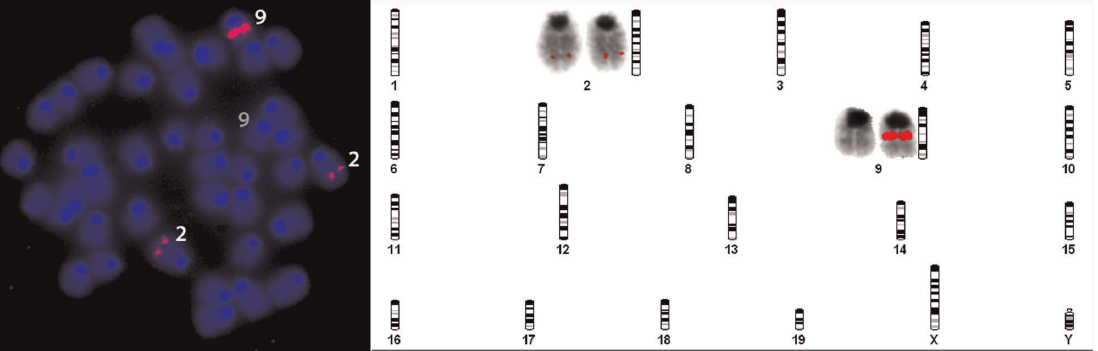
Figure 1. Fluorescent In Situ Hybridization for SVCT2. FISH analysis localized the SVCT2 transgene to one copy of chromosome 9 ( # 9), whereas the native version was found on both copies of chromosome 2 ( # 2). Brighter signal indicates multiple copies of the transporter at the insertion site.